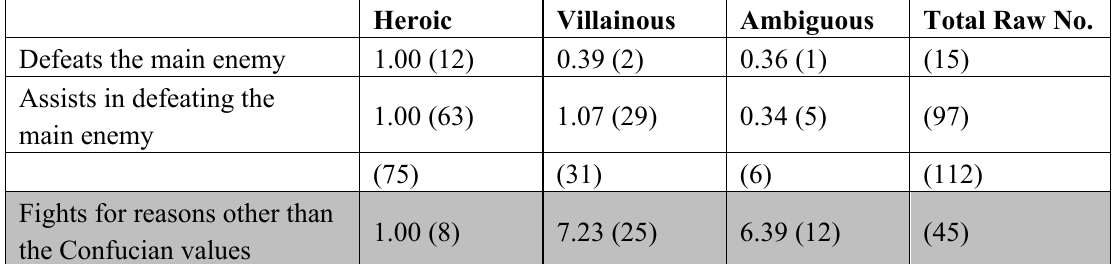
Table 3. Normalized index of the nuxia characters’ fighting